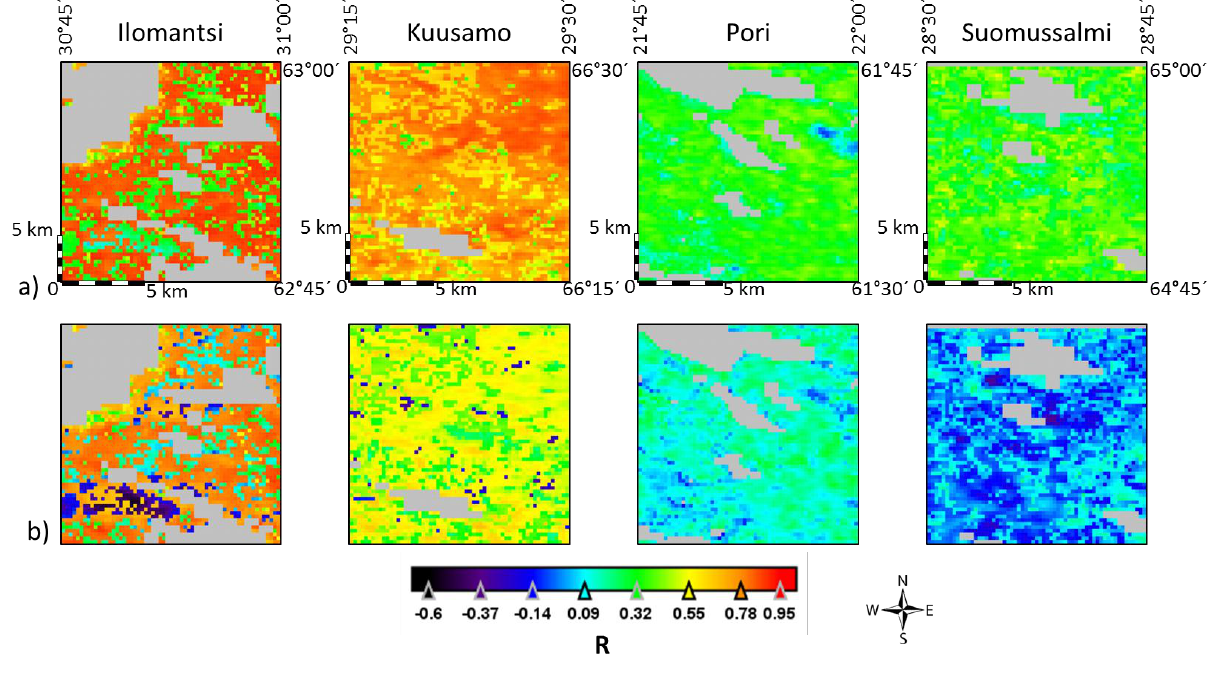
Figure 10. ( a ) ASAR SM vs. ECV SM and ( b ) ASAR SM vs. in situ SM correlation maps evaluated for each ASAR WS pixel (1 km × 1 km after resampling) within the GTK ECV size